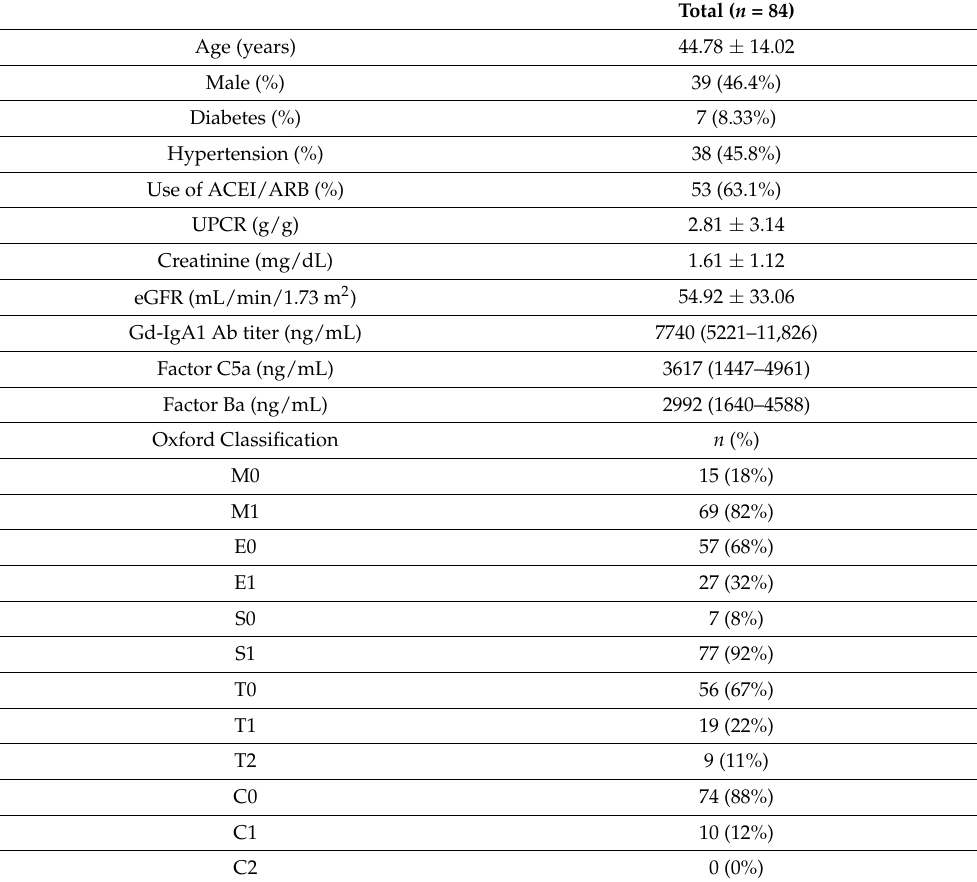
Table 1. Baseline characteristics of all IgAN